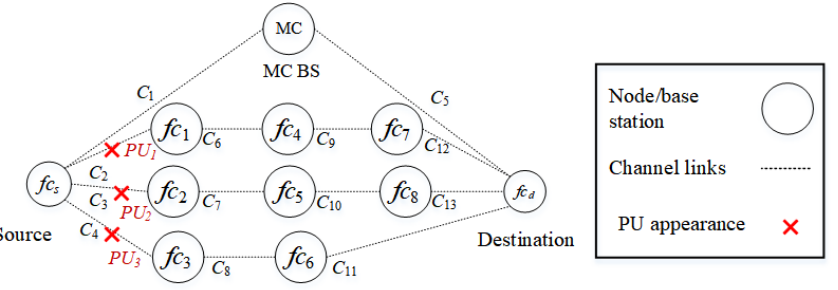
Figure 8. Scenario 3: The appearance of PUs in routes k 2 , k 3 , and k 4 interfere with channels c 2 , c 3 , and c 4